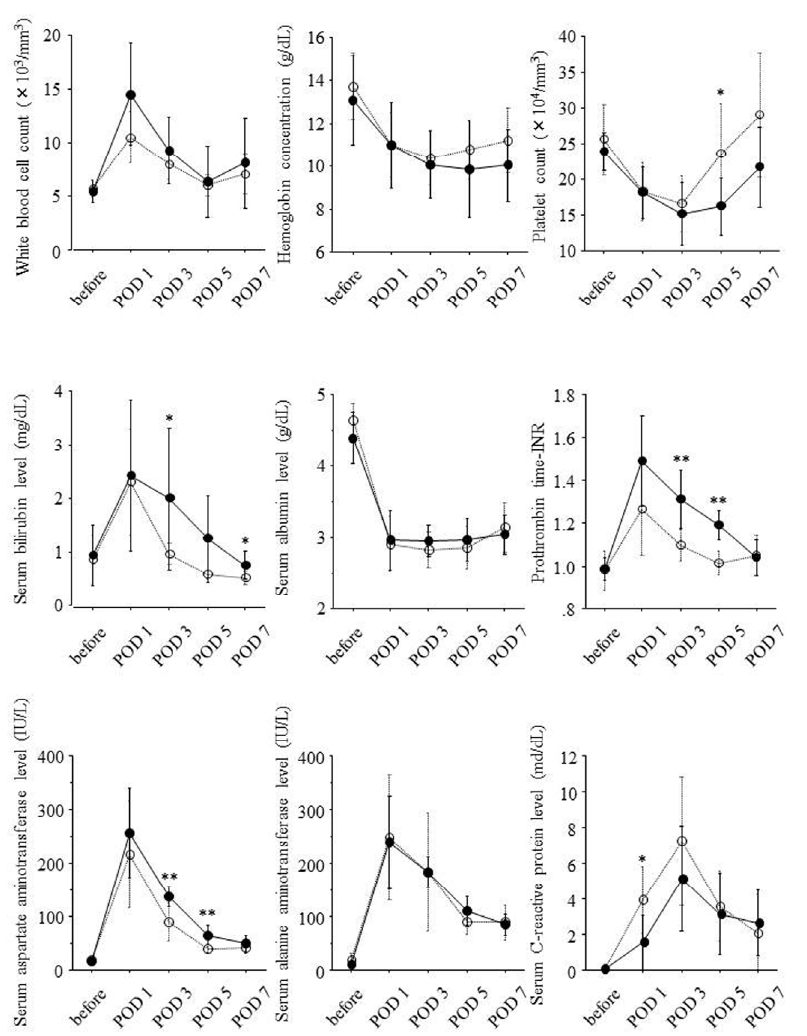
Figure 3. Associations of liver regeneration with serial changes of laboratory data during the clinical course. Solid and dotted lines show serial changes of laboratory data in eight patients showing ratio of liver volume on POD 14 to liver volume on POD 0 of 150% or higher and the other eight patients showing this ratio <150%, respectively. Serum levels of each laboratory data before hepatectomy and on POD 1, 3, 5 and 7 were expressed as mean ± standard deviation. Before: before partial hepatectomy; POD: postoperative day; *: p < 0.05; **: p <